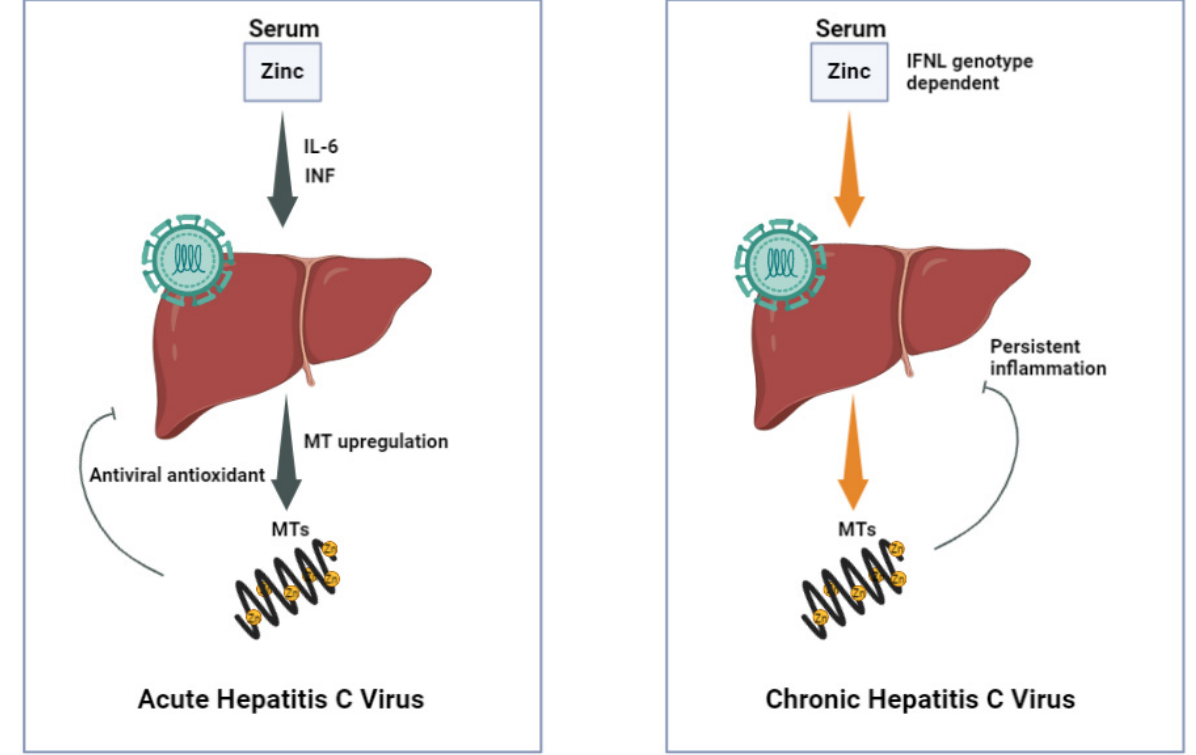
Figure 1. Roles of serum zinc and methallothionein in acute versus chronic hepatitis C virus (HCV).